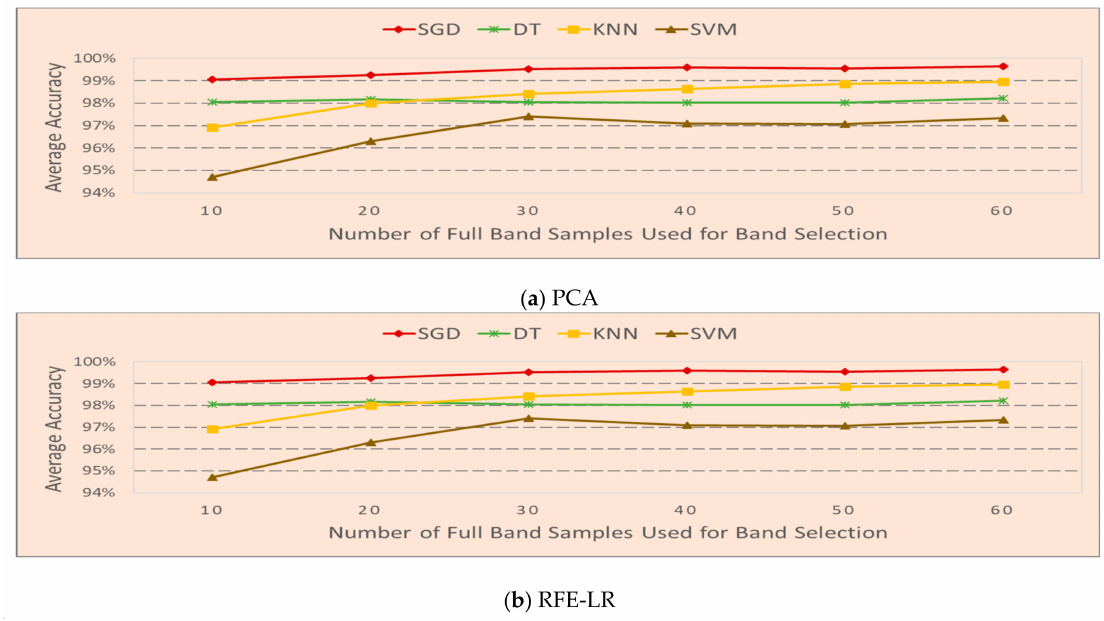
Figure 6. Average accuracy vs. number of samples used for bands selection.